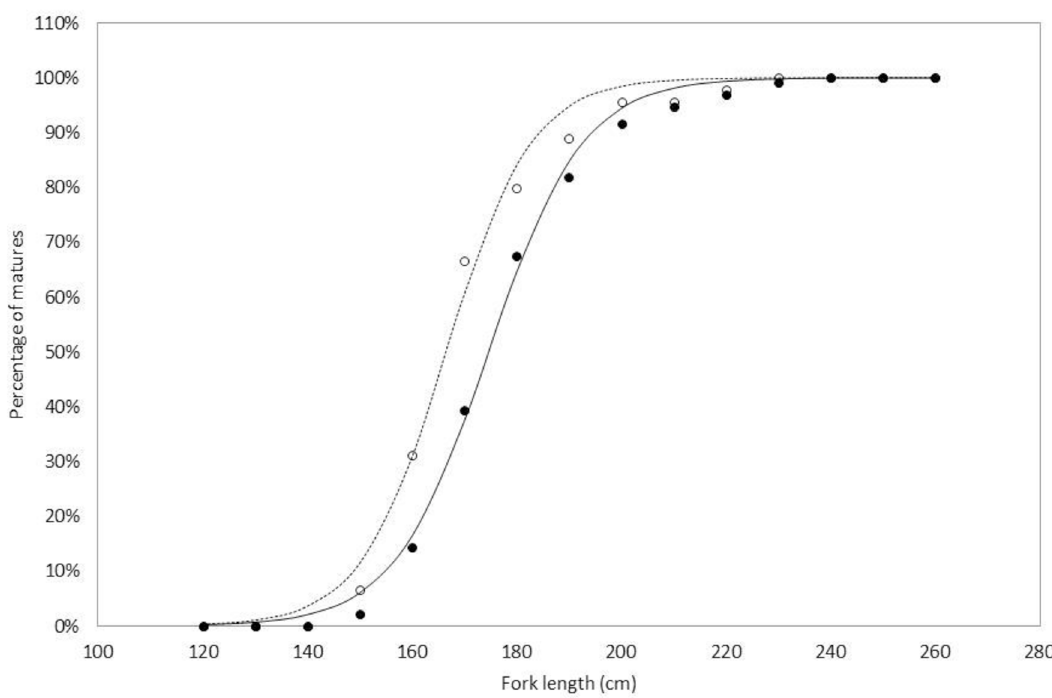
Fig 8. Length at sexual maturity of Sardinella maderensis . Measured male (white dots), measured female (black dots). Expected distribution of mature individuals is represented by a solid line for females and a dashed line for males.